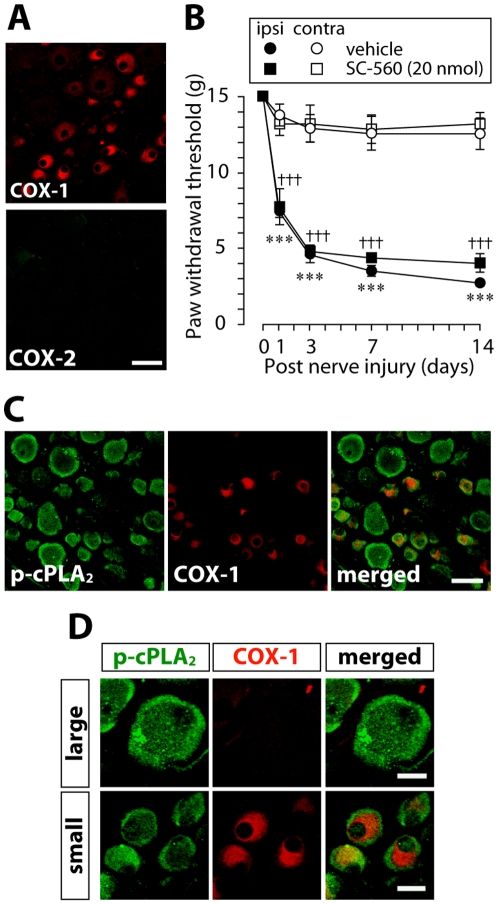
A COX inhibitor does not prevent the development of tactile allodynia after nerve injury.A. Immunofluorescence labeling of COX-1 and COX-2 proteins in the L5 DRG 14 days after nerve injury demonstrated that immunoreactivity of COX-1, but not COX-2, was present mainly in small-sized neurons. Scale bar, 50 µm. B. The COX-1 inhibitor SC-560 (20 nmol/10 µl) administered through a catheter whose tip was positioned near the L5 DRG once daily for 14 days did not suppress the development of nerve injury-induced a decrease in the paw withdrawal threshold of tactile stimulation using von Frey filaments. ***p<0.001 compared with the threshold of the vehicle-treated group on day 0. †††p<0.001 compared with the threshold of the inhibitor-treated group on day 0. Data are presented as mean ± SEM of the paw withdrawal threshold of five animals. C. Double immunofluorescence labeling of p-cPLA2 with COX-1 in L5 DRG neurons 14 days after nerve injury showed that most of neurons with the translocated p-cPLA2 were not double-labeled with COX-1-IR. Scale bar, 50 µm. D. Highly magnified pictures of large and small diameter DRG neurons demonstrated that in large neurons, p-cPLA2 was not co-expressed with COX-1-IR. In small neurons, the subcellular localizations of p-cPLA2 and COX-1-IR were different: COX-1-immunoreactivity was observed in the perinuclear area where p-cPLA2- immunoreactivity was not accumulated. Scale bars, 20 µm.